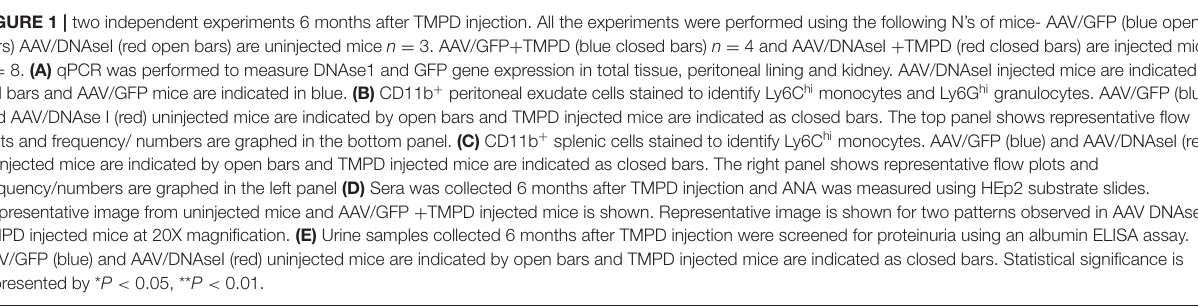
FIGURE 1 | two independent experiments 6 months after TMPD injection. All the experiments were performed using the following N’s of mice- AAV/GFP (blue open bars) AAV/DNAseI (red open bars) are uninjected mice n = 3. AAV/GFP + TMPD (blue closed bars) n = 4 and AAV/DNAseI + TMPD (red closed bars) are injected mice n = 8. (A) qPCR was performed to measure DNAse1 and GFP gene expression in total tissue, peritoneal lining and kidney. AAV/DNAseI injected mice are indicated in red bars and AAV/GFP mice are indicated in blue. (B) CD11b + peritoneal exudate cells stained to identify Ly6C hi monocytes and Ly6G hi granulocytes. AAV/GFP (blue) and AAV/DNAse I (red) uninjected mice are indicated by open bars and TMPD injected mice are indicated as closed bars. The top panel shows representative flow plots and frequency/ numbers are graphed in the bottom panel. (C) CD11b + splenic cells stained to identify Ly6C hi monocytes. AAV/GFP (blue) and AAV/DNAseI (red) uninjected mice are indicated by open bars and TMPD injected mice are indicated as closed bars. The right panel shows representative flow plots and frequency/numbers are graphed in the left panel (D) Sera was collected 6 months after TMPD injection and ANA was measured using HEp2 substrate slides. Representative image from uninjected mice and AAV/GFP + TMPD injected mice is shown. Representative image is shown for two patterns observed in AAV DNAseI TMPD injected mice at 20X magnification. (E) Urine samples collected 6 months after TMPD injection were screened for proteinuria using an albumin ELISA assay. AAV/GFP (blue) and AAV/DNAseI (red) uninjected mice are indicated by open bars and TMPD injected mice are indicated as closed bars. Statistical significance is represented by * P < 0.05, ** P <